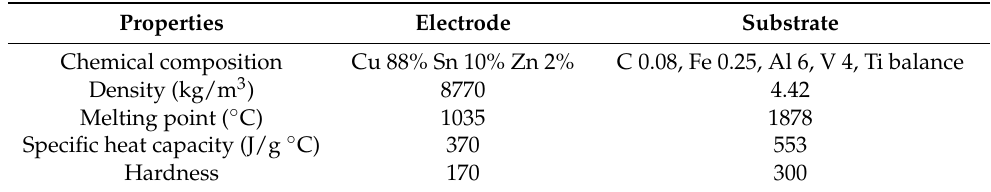
Table 1. Physical and Chemical Composition of Electrode and Substrate.